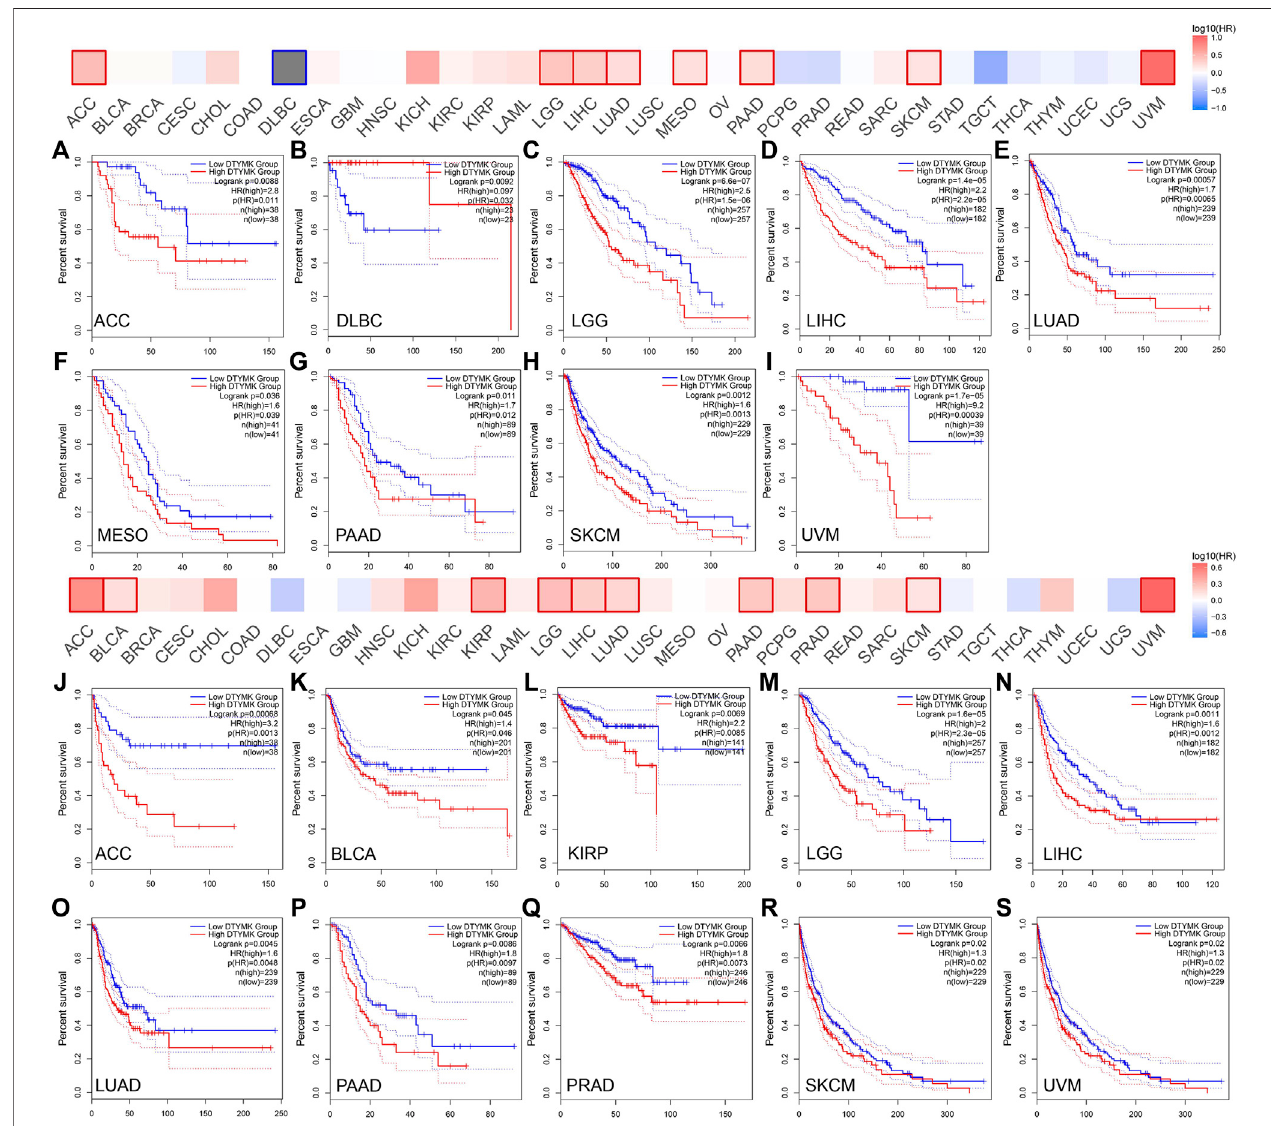
FIGURE10| TheGEPIAdatabasesuggeststhathigherDTYMKexpression correlateswithworseprognosisinmostcancers.DTYMKexpressionwassigni fi cantly correlated with overall survival of ACC (A) , DLBC (B) , LGG (C) , LIHC (D) , LUAD (E) , MESO (F) , PAAD (G) , SKCM (H) , and UVM (I) . DTYMK expression was signi fi cantly correlatedwithdisease-freesurvivalofACC (J) ,BLCA (K) ,KIRP (L) ,LGG (M) ,LIHC (N) ,LUAD (O) ,PAAD (P) ,PRAD (Q) ,SKCM (R) ,and UVM (S) .ACC,Adrenocortical carcinoma;DLBC,diffuselargeB-celllymphoma;BLCA,Bladderurothelialcarcinoma;KIRP,Kidneyrenalpapillary cellcarcinoma;LGG,Brainlower gradeglioma; LIHC, Liver hepatocellular carcinoma; LUAD, Lung adenocarcinoma; LUSC, Lung squamous cell carcinoma; MESO, Mesothelioma; PAAD, Pancreatic adenocarcinoma; PRAD, Prostate adenocarcinoma; SKCM, Skin cutaneous melanoma; UVM, Uveal